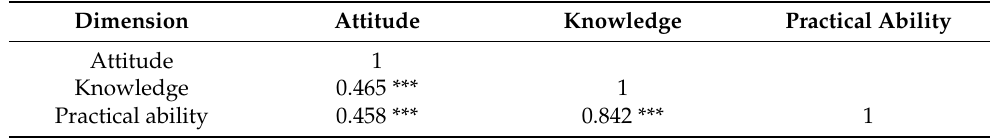
Table 7. Pearson correlation analysis amongst attitude, knowledge, and practical ability. Dimension Attitude Knowledge Practical Ability Attitude 1 Knowledge 1 Practical